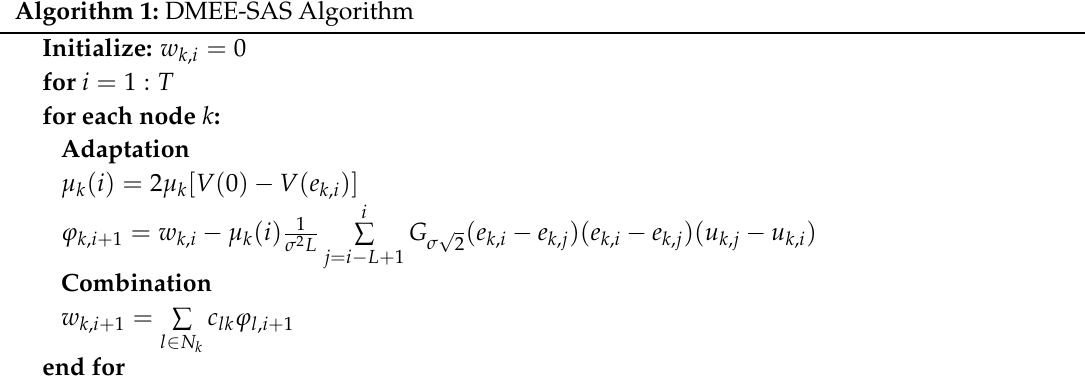
Algorithm 1: DMEE-SAS